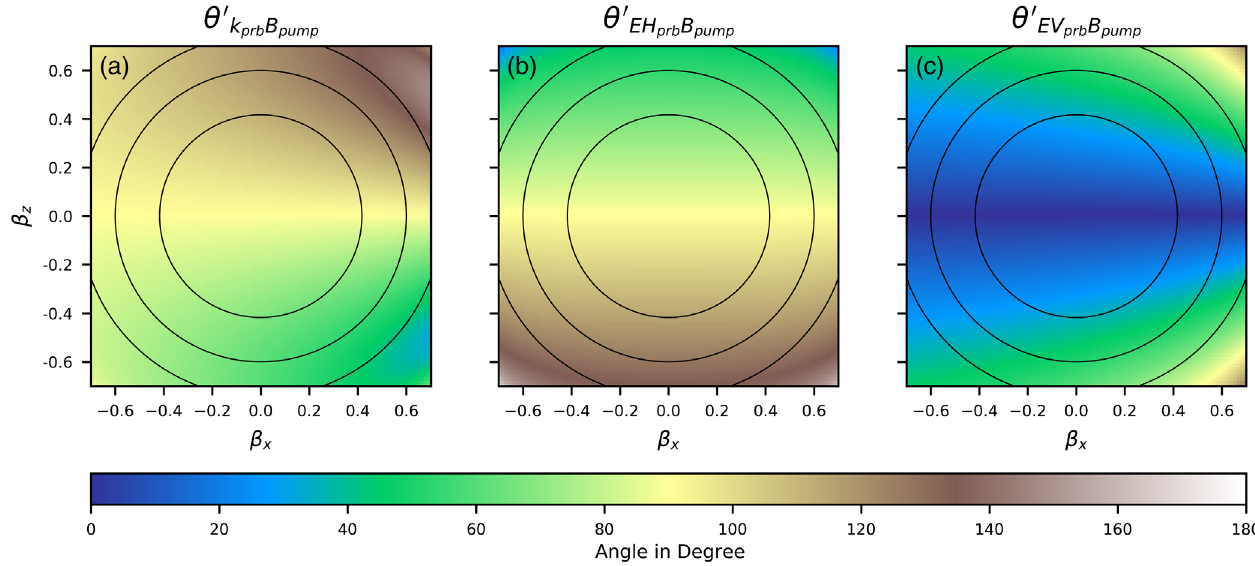
FIG. 10. Subplots show the change in vector orientation for electron drift motion in the xz plane. β i ¼ v i = c with i ¼ x ; z . (a) Angle between the probe ’ s propagation vector k prb and the pump ’ s magnetic field B pump . (b) Angle between the electric field of the H-pol probe EH prb and the pump ’ s magnetic field B pump . (c) Angle between the electric field of the V-pol probe EV prb and the pump ’ s magnetic field B pump . The three black, solid contour lines show the locations of the equivalent gamma factors of 1.1, 1.25, and